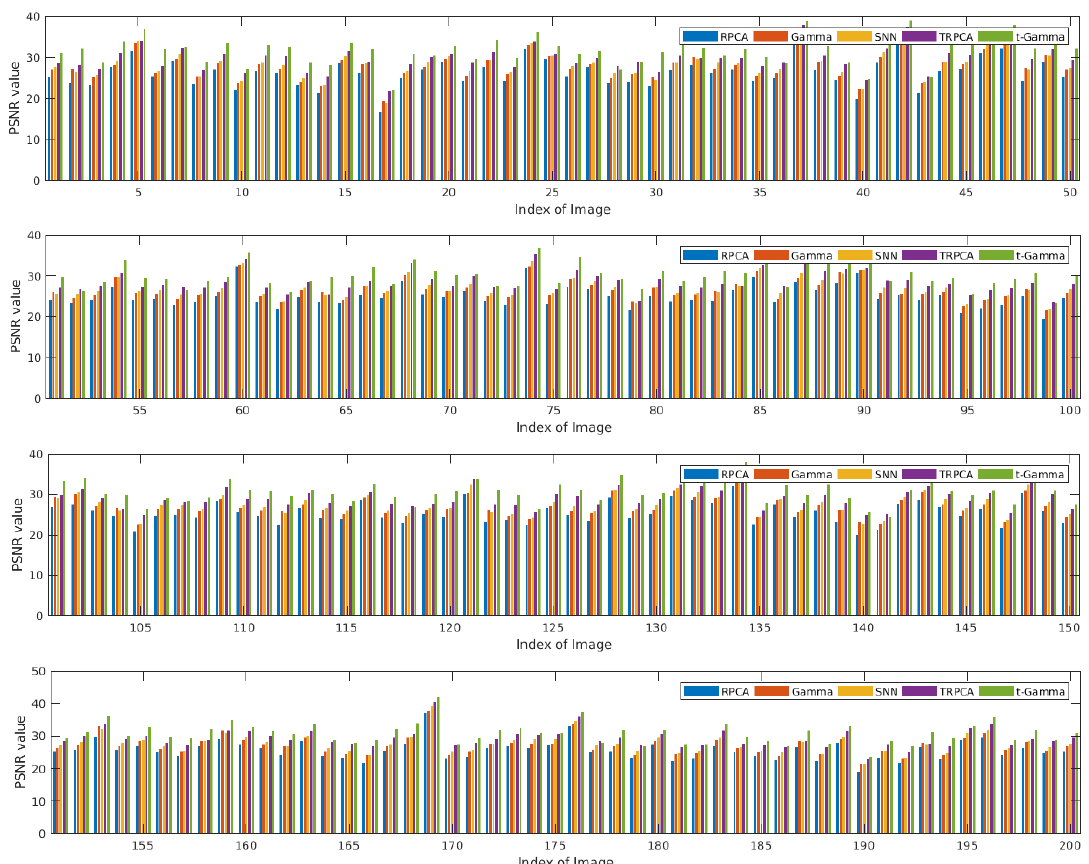
Figure 1. Comparison of the PSNR values with RPCA [4], Gamma [26], SNN [49], TRPCA [20] and t-Gamma.